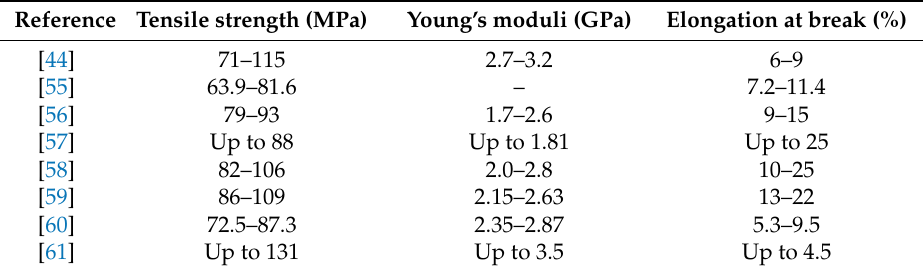
Table 2. Summary of the mechanical